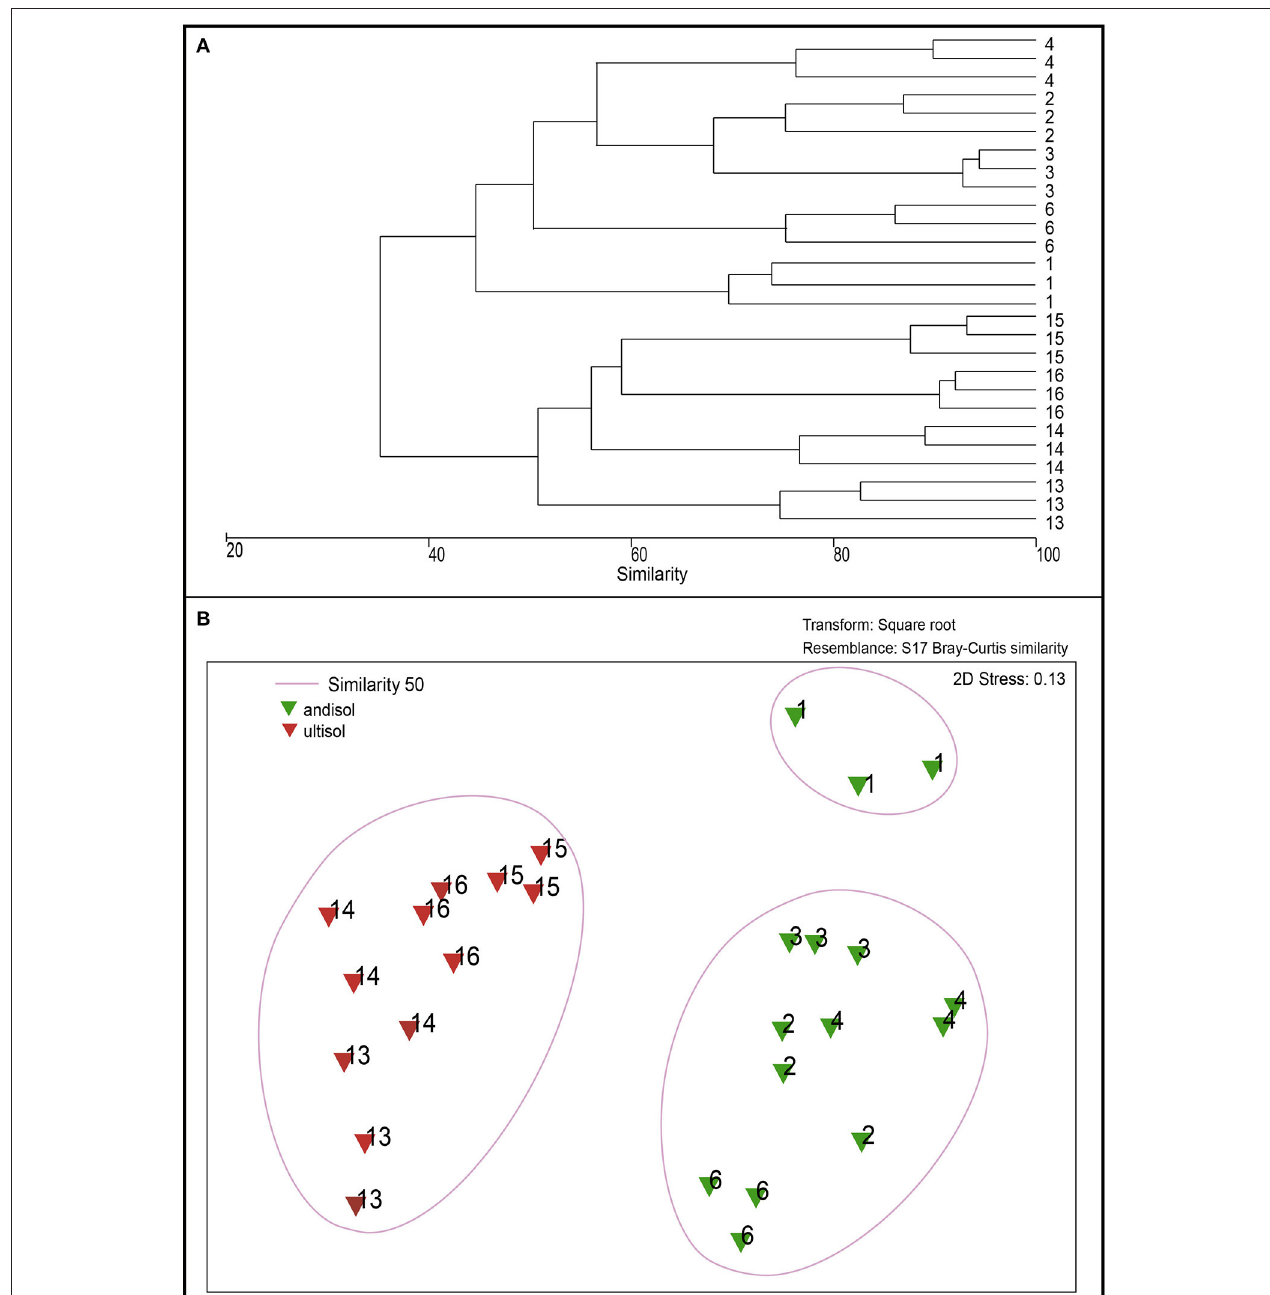
FIGURE 7 | Dendrogram of DGGE profiles (A) and non-metric Multidimensional Scaling (NMDS) analysis (B) of bacterial communities in the rhizosphere of soils from the greenhouse experiment (soils 2, 3, 4, 13, 14, 15, and 16) compared with Ggt-conducive soil (soil